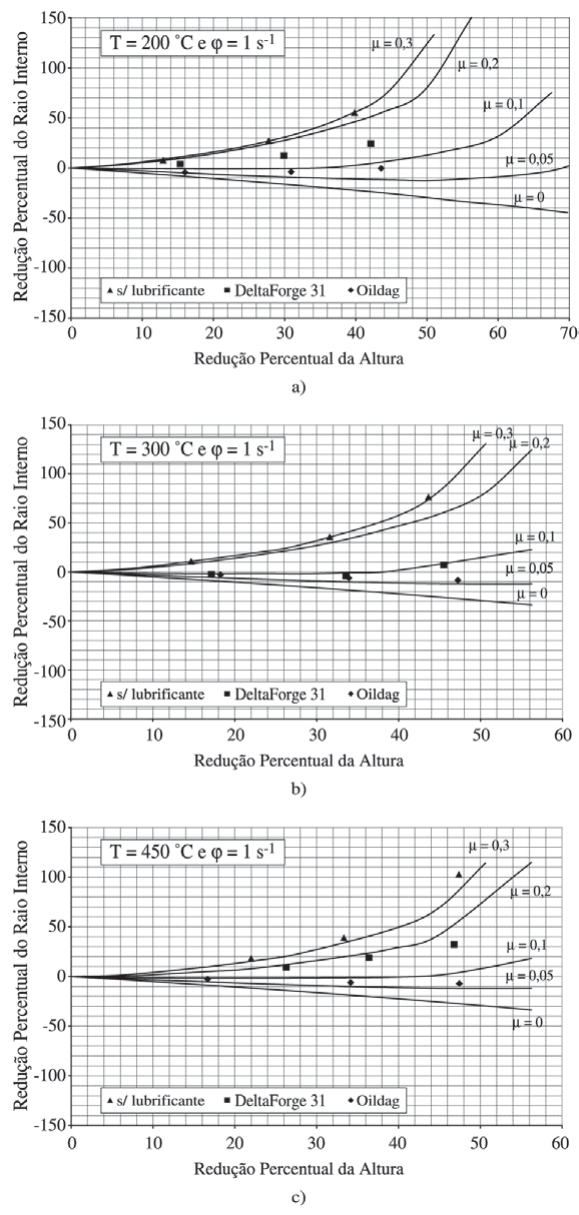
Figura 7. Curvas de Calibração e Resultados de Atrito a) T = 200 °C, 1 s -1 ; b) T = 300 °C, 1 s -1 ; c) T = 450 °C, 1 s -1 .